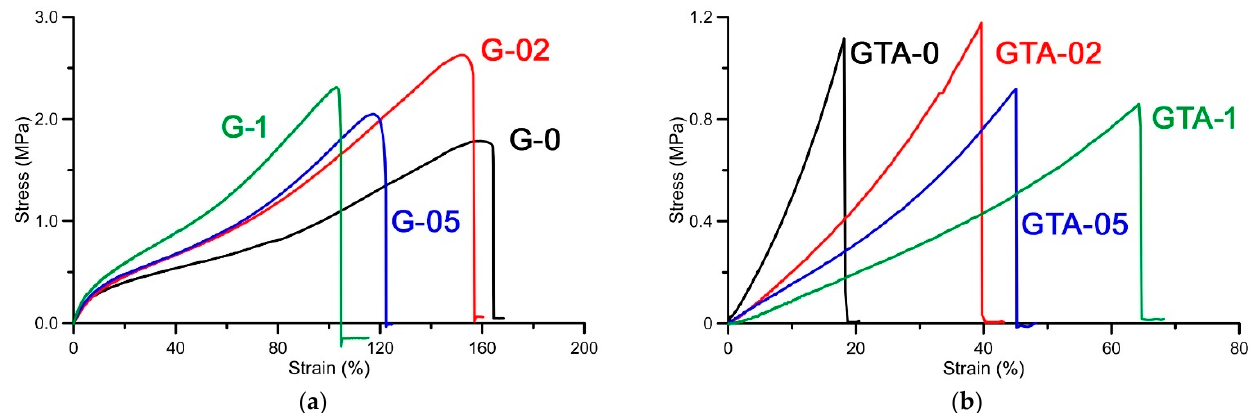
( b ) Figure 8. X-rays diffraction patterns of ( a ) G films and ( b ) GTA films. The low angle peak at about 7.5 °/2 θ , which is related to the diameter of the triple helix portions of gelatin, is absent in the XRD pattern of GTA-0 (Figure 8b), suggesting that crosslinking with glutaraldehyde blocks the random coil conformation of gelatin and inhibits the partial regain of triple helix structure occurring during cooling. On the other hand, the relative intensity of this peak increases from GTA-02 to GTA-1, indicating that curcumin counteracts the negative effect of GTA on the partial renaturation of the collagen structure, most likely by reducing the number of available sites for covalent interactions of gelatin with glutaraldehyde. 3.6. Mechanical Properties Functionalization with curcumin influences also the mechanical properties of gelatin